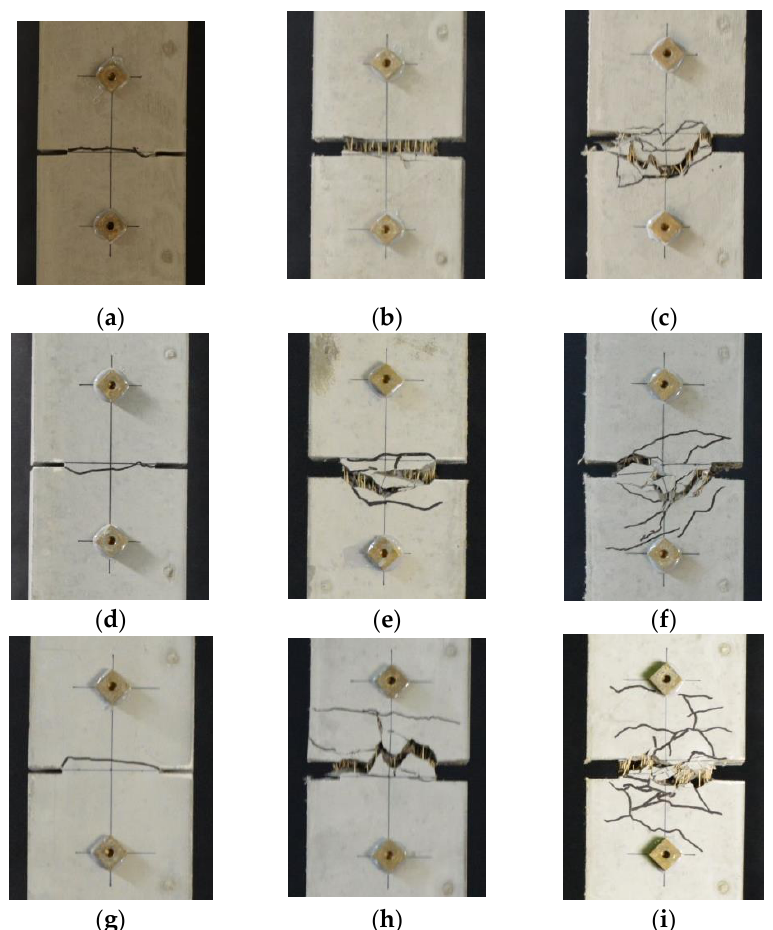
Figure 5. Examples of crack pattern (tensile failure): ( a ) Fc24-N; ( b ) Fc24-1%; ( c ) Fc24-2%; ( d ) Fc36-N; ( e ) Fc36-1%; ( f ) Fc36-2%; ( g ) Fc48-N; ( h ) Fc48-1%; ( i )